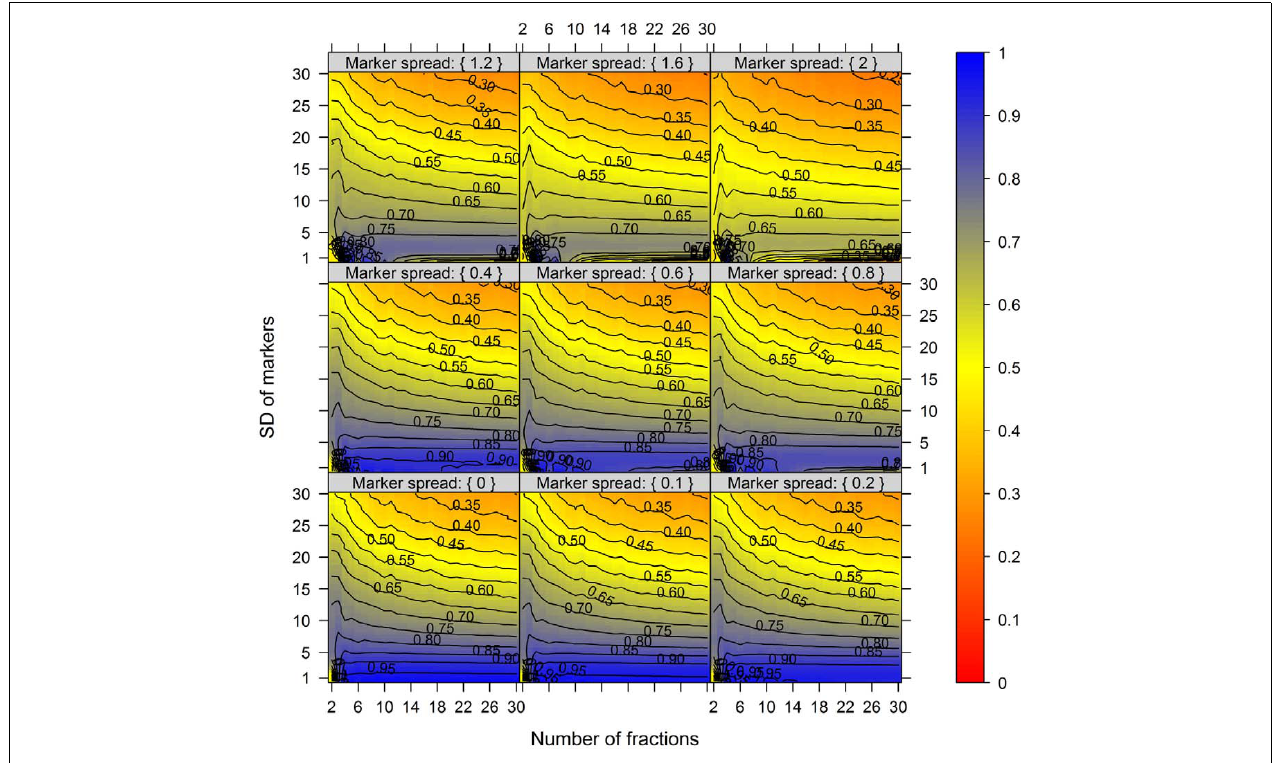
FIGUREA4 |The cluster validity in dependence of the number of collected fractions, the SD of markers, and the marker spread for the five-compartmental model. The cluster validity index is depicted for 5 compartments each represented by 3 markers. For further details see FigureA2 .